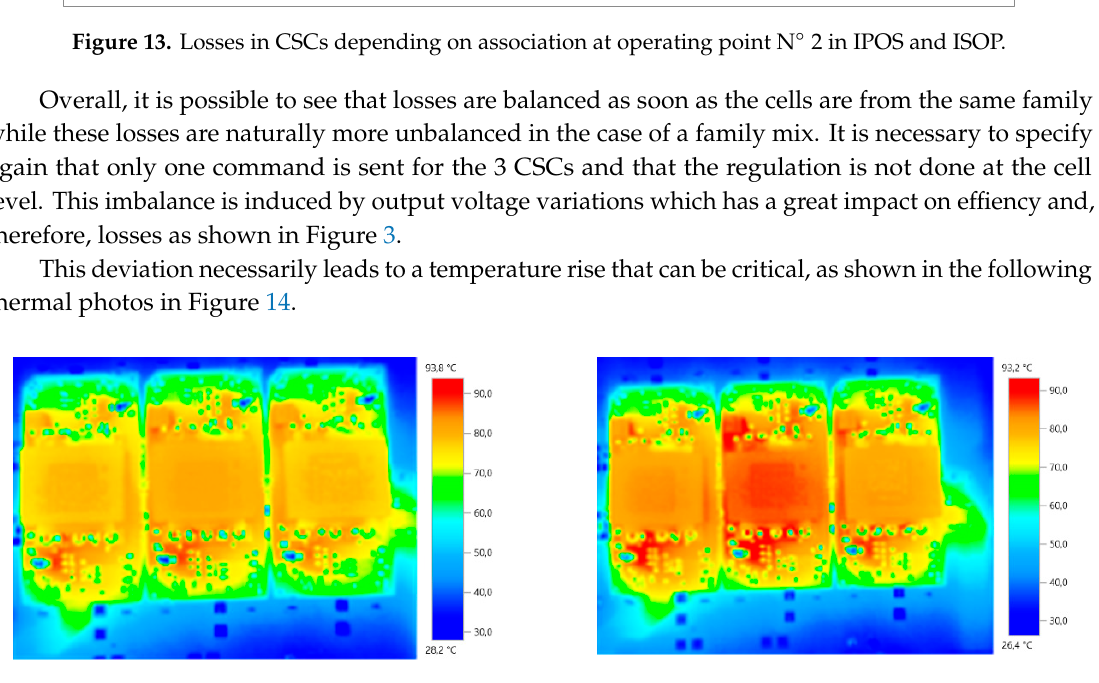
Figure 15. Thermal image of ACA arrangement for the following operating point of Vin = 45 V; Vout = 13.7 V; Pout = 90 W.